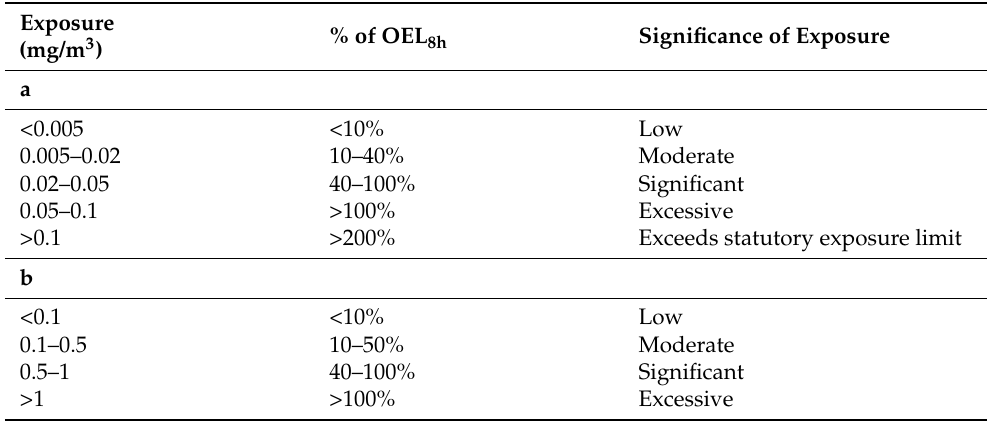
Table 1. ( a ) Classification of quartz exposure. ( b ) Classification of exposure to respirable